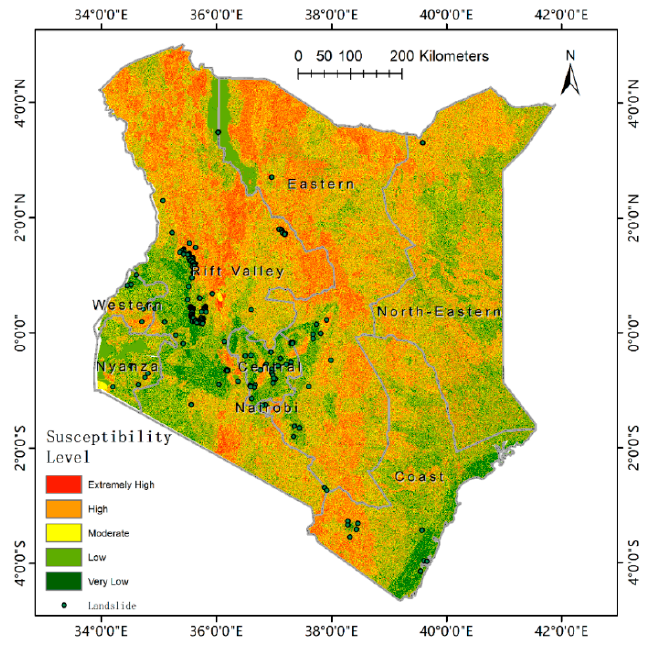
Figure 10. The landslide susceptibility map produced using the conventional AHP.